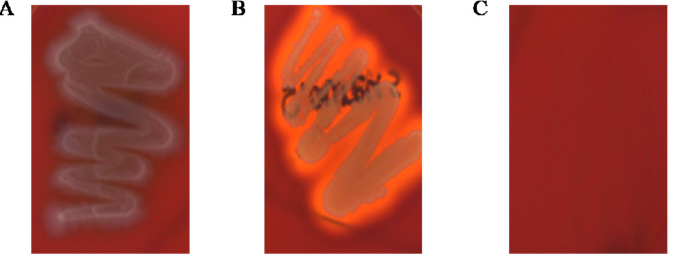
Figure 4. Hemolytic activities of L. reuteri KGC1901, Escherichia coli, and Staphylococcus aureus . E. coli shows typical α -hemolysis ( A ), and S. aureus shows typical β -hemolysis ( B ). However, L. reuteri KGC1901 ( C ) does not show any lysis of blood cells.